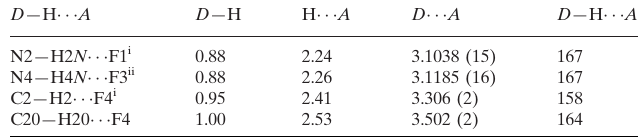
Bruker APEXII CCD diffractometer Absorption correction: multi-scan ( SADABS ; Bruker, 2008)